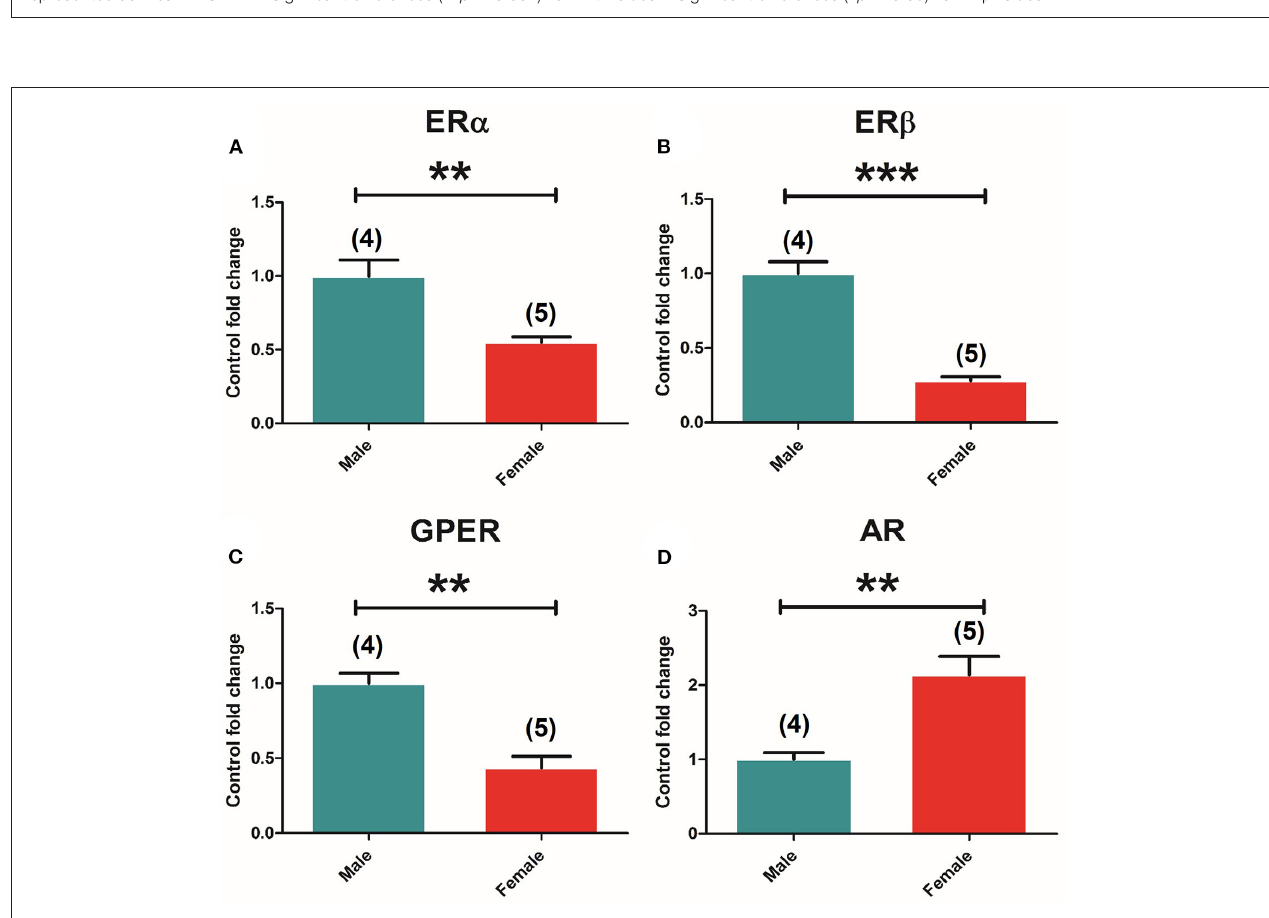
FIGURE 3 | Sexual differences in ER and AR expression in the pituitary gland. (A) ER α mRNA levels. (B) ER β mRNA levels. (C) GPER mRNA levels. (D) AR mRNA levels in male and female animals. Male animals ( n = 4) and female animals ( n = 5). Data are represented as mean ± SEM. ** p < 0.01; ***Significant differences (*** p < 0.001) vs. male control